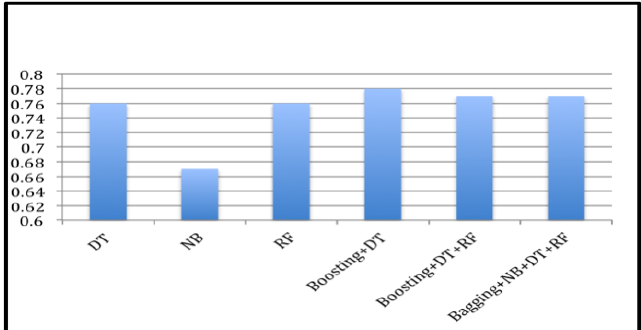
Figure 13. The precision of DM and ensemble